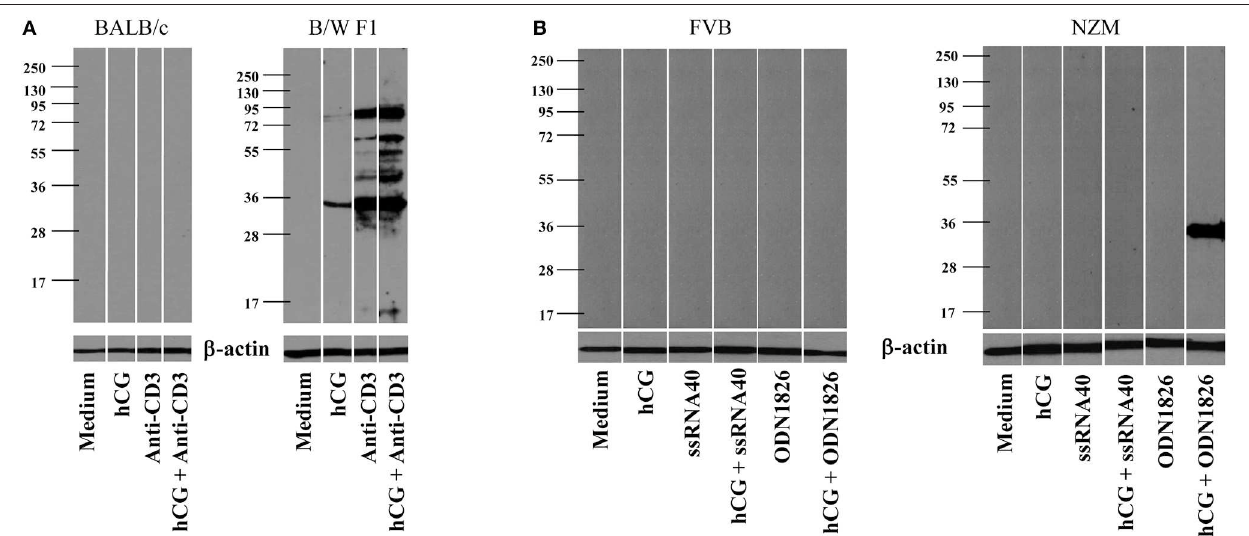
FIGURE 3 | Generation of autoantibodies from splenocytes cultures. (A) Splenocytes isolated from BALB/c (Left) or B/W F1 (Right) mice were incubated with Medium, hCG, anti-CD3 antibodies, or hCG + anti-CD3 antibodies. Supernatants were assessed for reactivity toward apoptotic blebs by Western blot. Reactivity of anti- β actin antibodies was employed to verify equivalence of loading. (B) Splenocytes isolated from FVB (Left) or NZM (Right) mice were incubated with Medium, hCG, ssRNA40, hCG + ssRNA40, ODN1826, or hCG + ODN1826. Supernatants were assessed for reactivity toward apoptotic blebs by Western blot. Reactivity of anti- β actin antibodies was employed to verify equivalence of